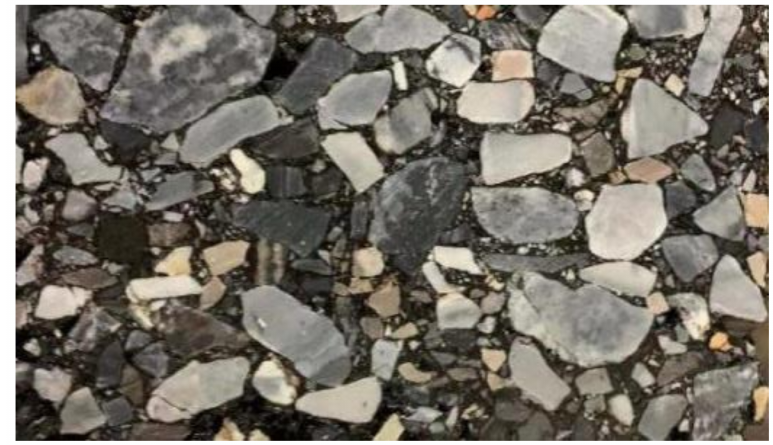
Figure 5. Internal condition of mixture during 50 times of rotary compaction.